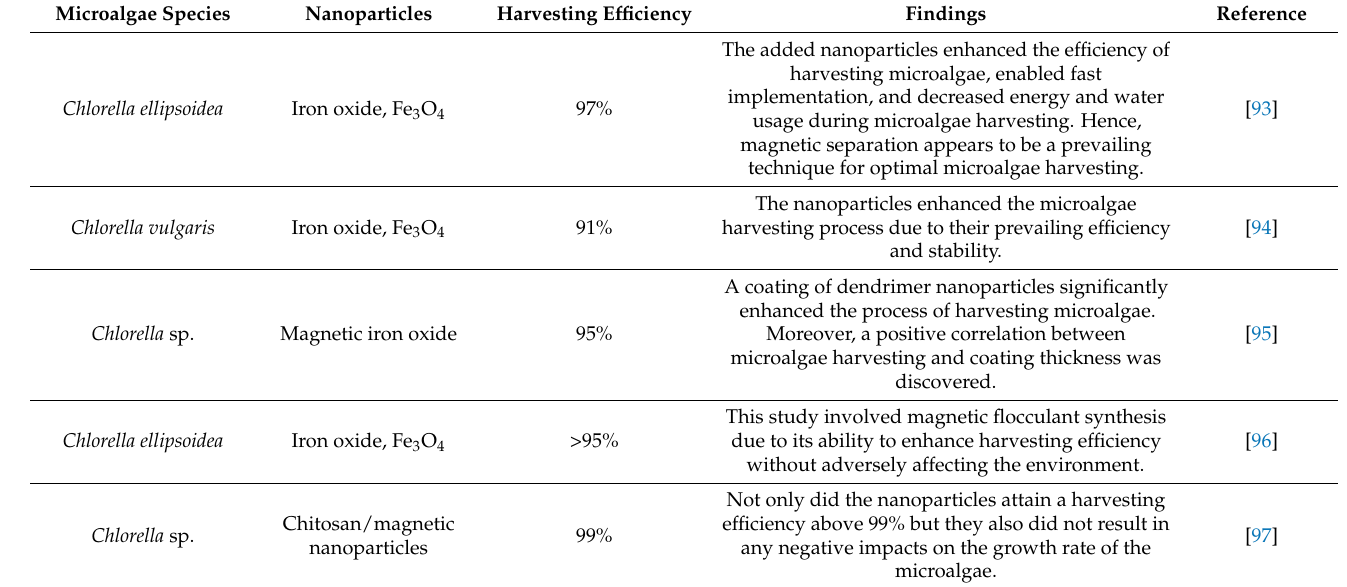
Table 3. A summary of the impacts of various nanoparticles on the harvesting efficiency of different microalgae